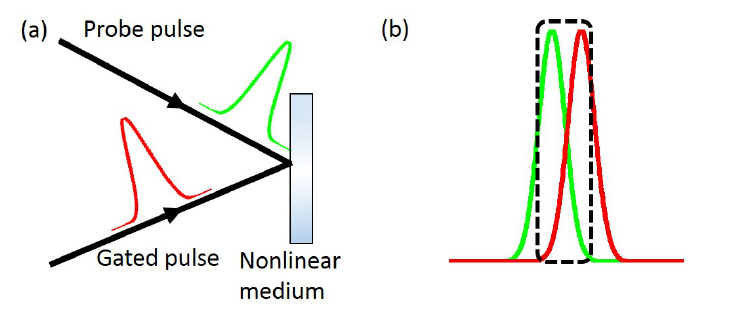
Figure 1. ( a ) The schematic when the probe pulse (green line) is incident on the nonlinear medium before the gated pulse (red line). ( b ) Reconstructable part of the probe pulse and the gated pulse. Assuming THG − FROG for simplicity and generality, the measured trace is represented